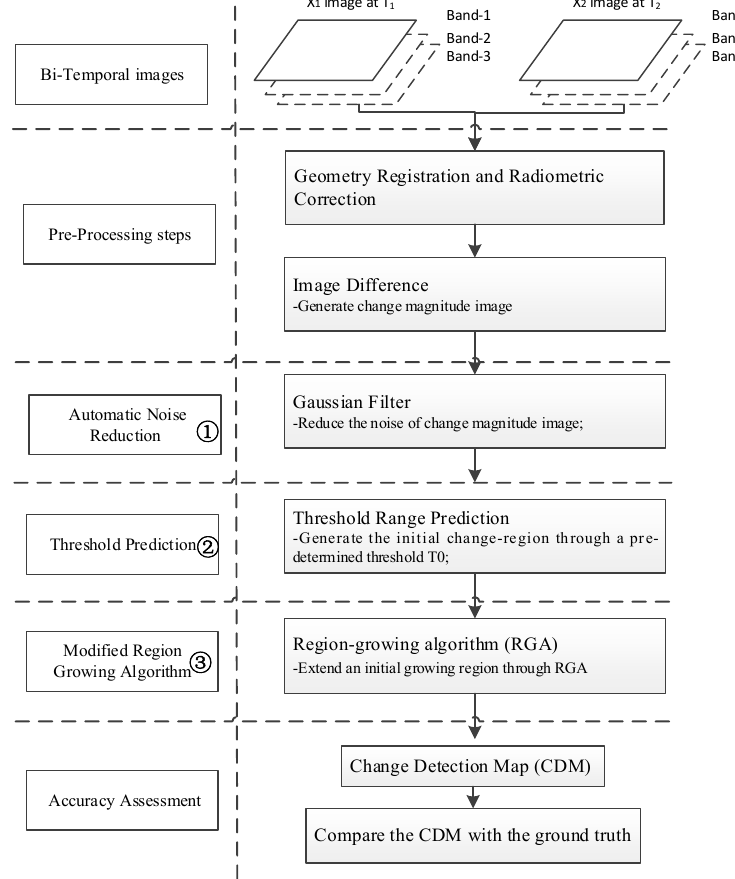
Figure 1. Processing chain of the proposed change detection system.